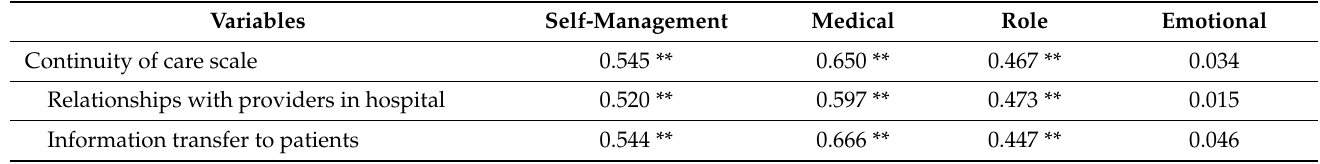
Table 4. Relationships between the continuity of care and self-management of patients with stroke ( N = 150).